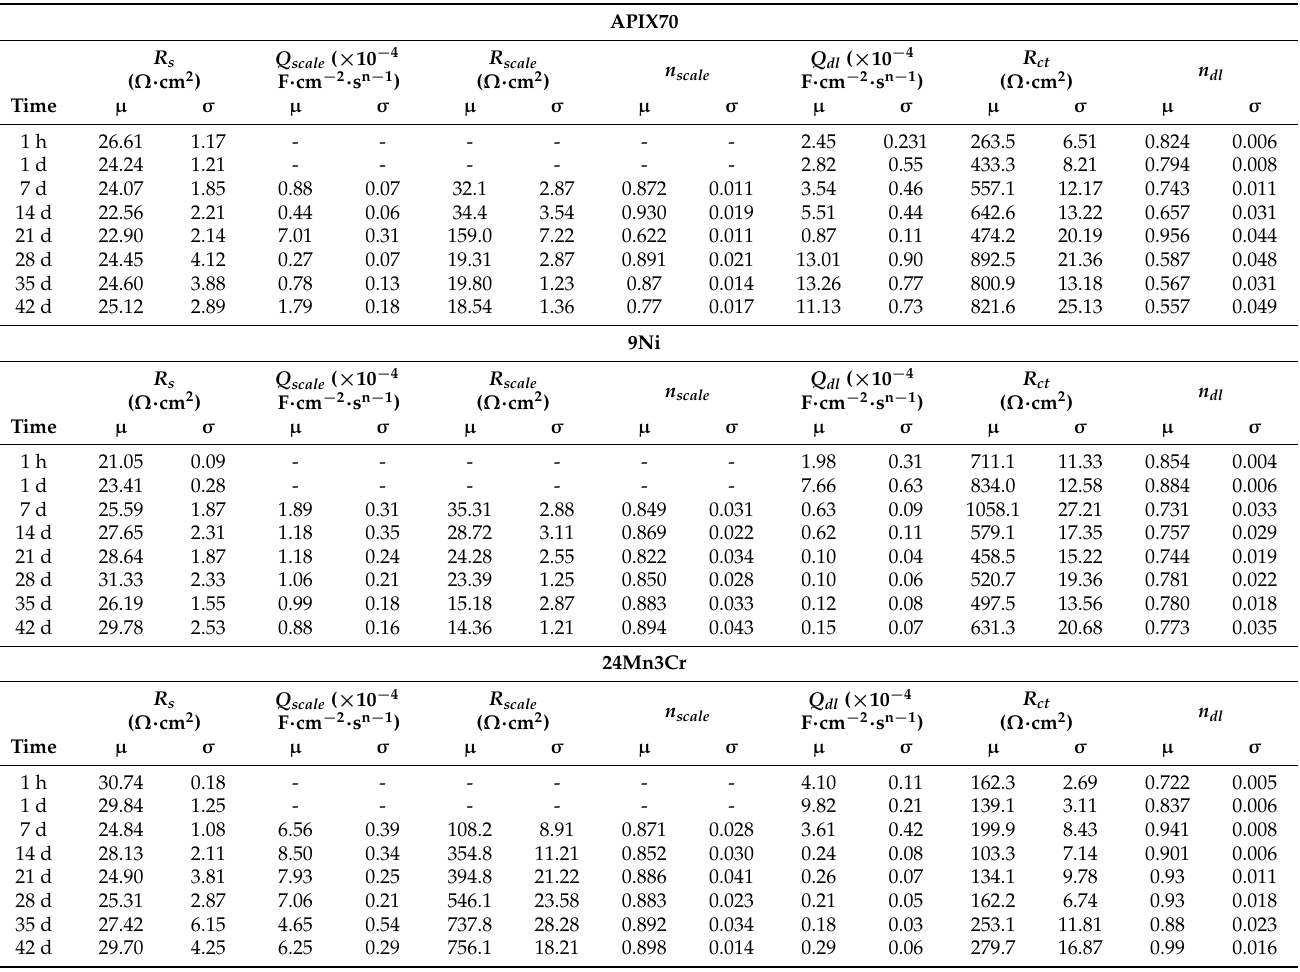
Table 3. Mean values ( µ ) and their standard deviations ( σ ) of several fitted parameters obtained by curve fitting to the Nyquist plots of the tested